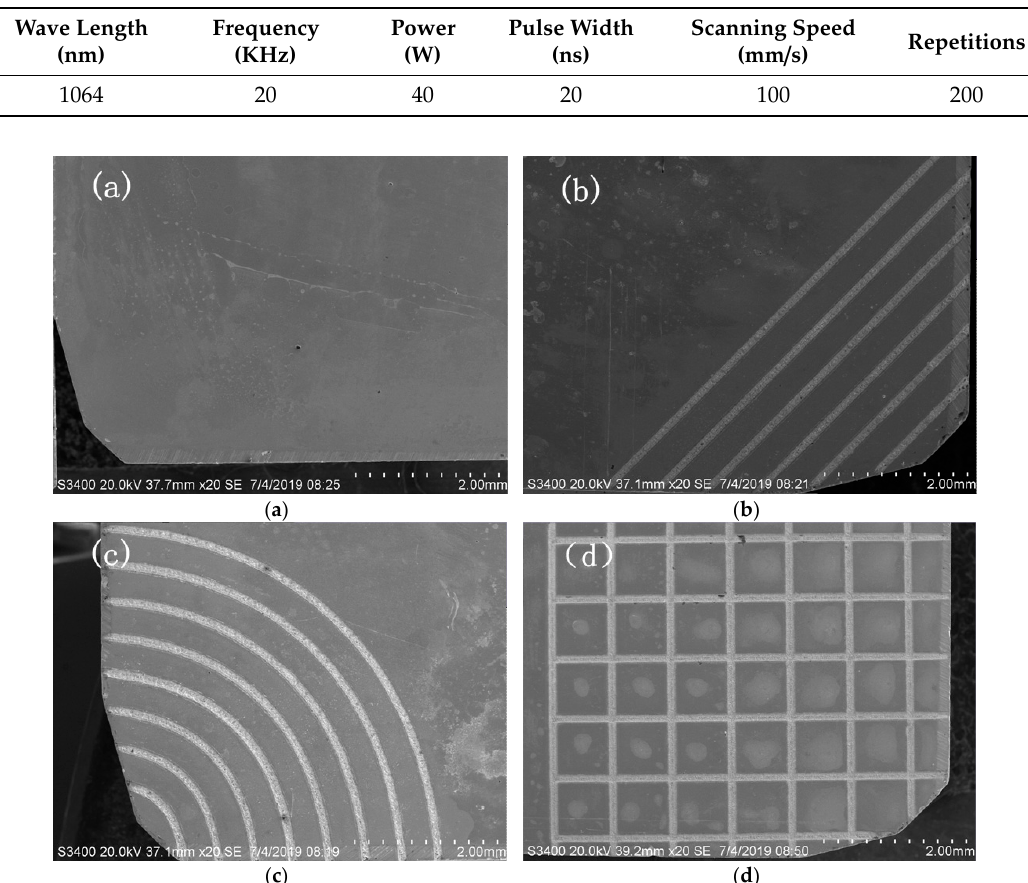
Figure 1. Surface micrographs of the four types of tools. ( a ) Non-textured tool; ( b ) Line textured tool; ( c ) Sinusoidal textured tool; ( d ) Rhombic textured tool.